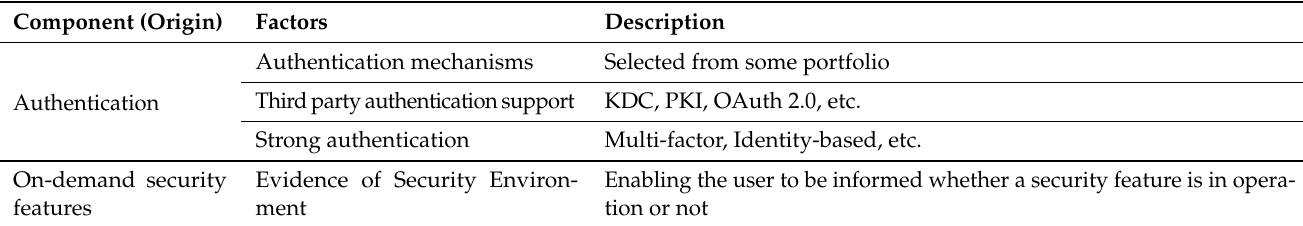
Table 5. SSLA components (SQO